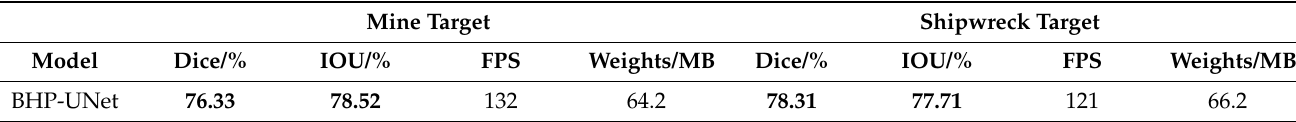
Table 3. Segmentation performances of the BHP-UNet model.